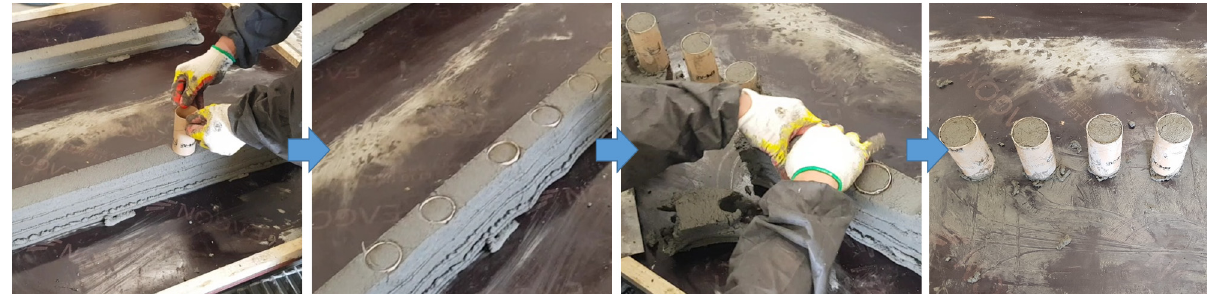
Figure 6. Production process of specimens by coring additive parts.